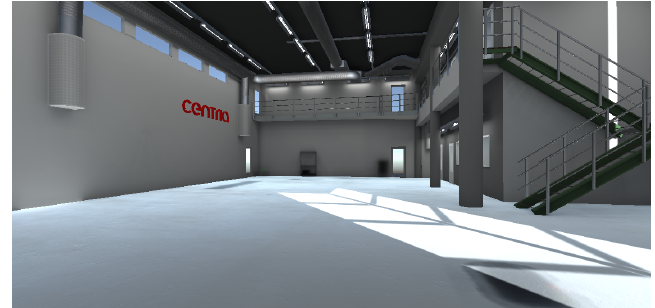
Figure 5. View of Robo3D Lab virtual